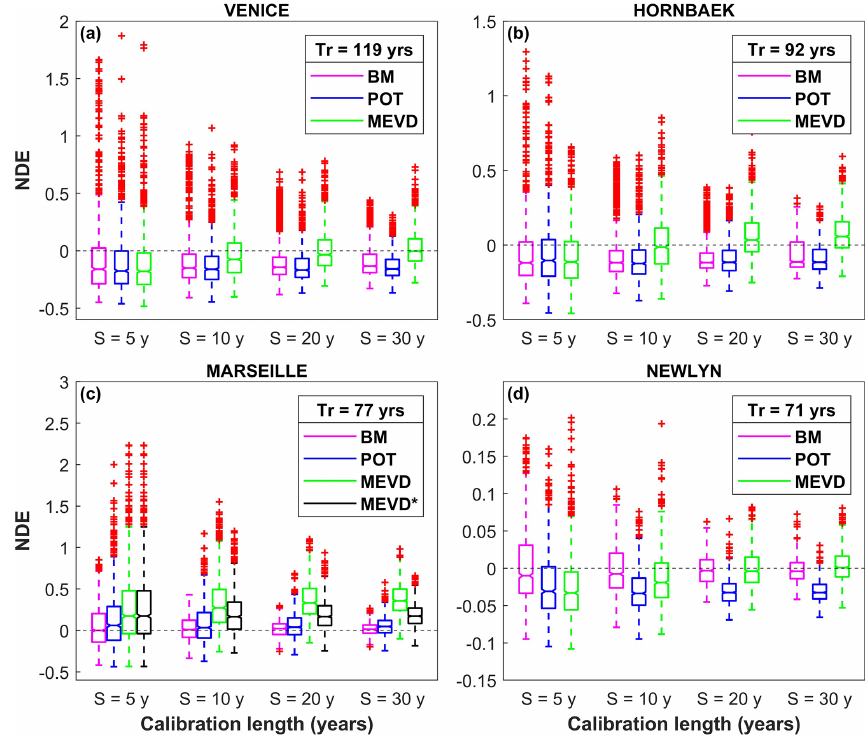
Figure 4. Distribution of the nondimensional error (NDE) for maximum sample return period ( T r ) represented by means of box plots at given gauge stations explored: ( a ) Venice (IT), ( b ) Hornbæk (DK), ( c ) Marseille (FR), ( d ) Newlyn. In the case of the Marseille (FR) site, MEVD parameter estimation is based (1) on non-overlapping sub-samples of fixed size (5 years; green color) and (2) on data from the whole calibration sample (black